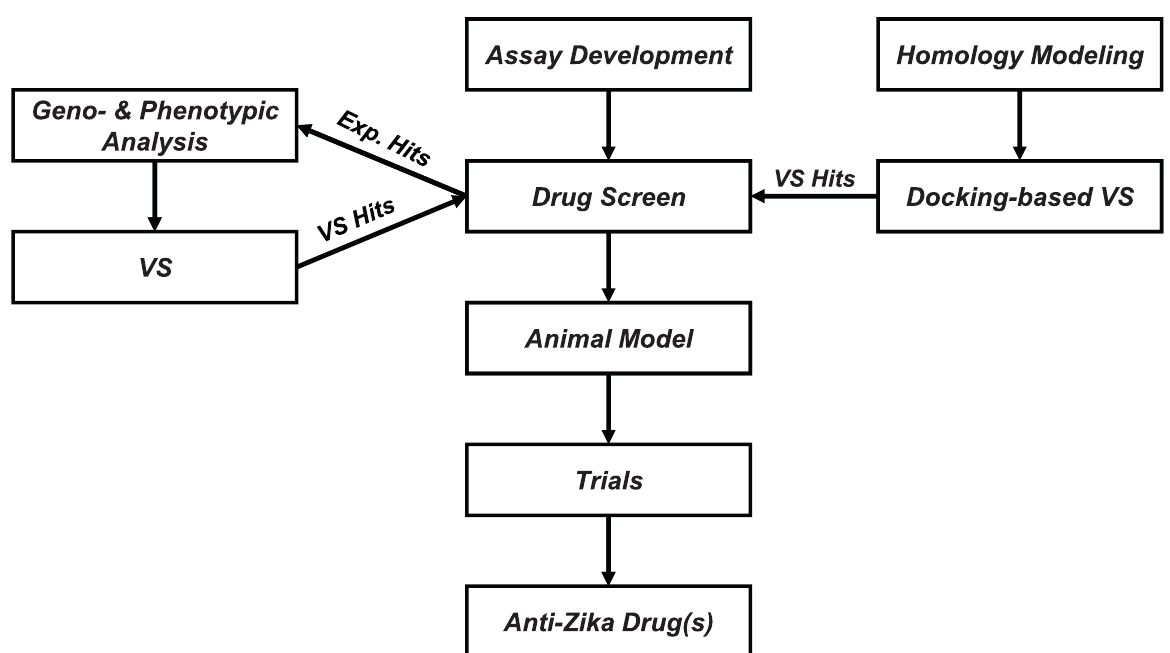
Figure 3. Proposed workflow for rapid drug discovery against Zika virus. Exp = experimental; VS = virtual